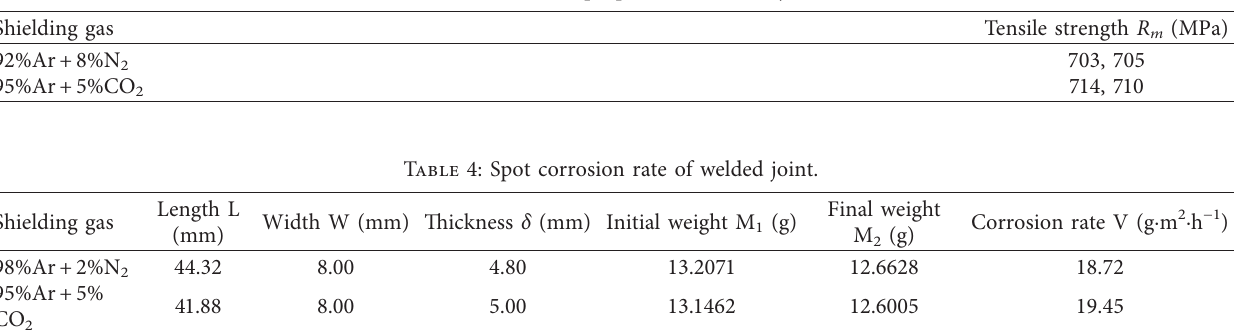
Figure 10: Test results of austenite grain size. Table 3: Mechanical properties of welded joints.